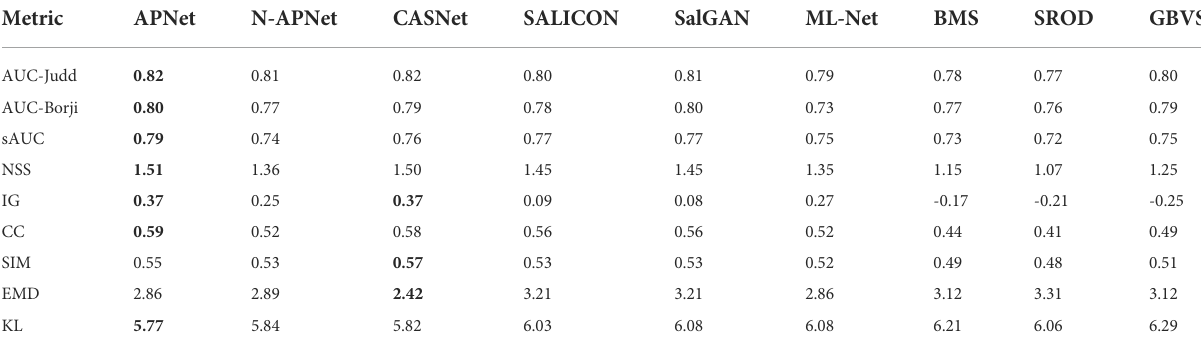
TABLE 4 Quantitative results on CAT2000 dataset. The best performance in each metric is highlighted in bold. Metric